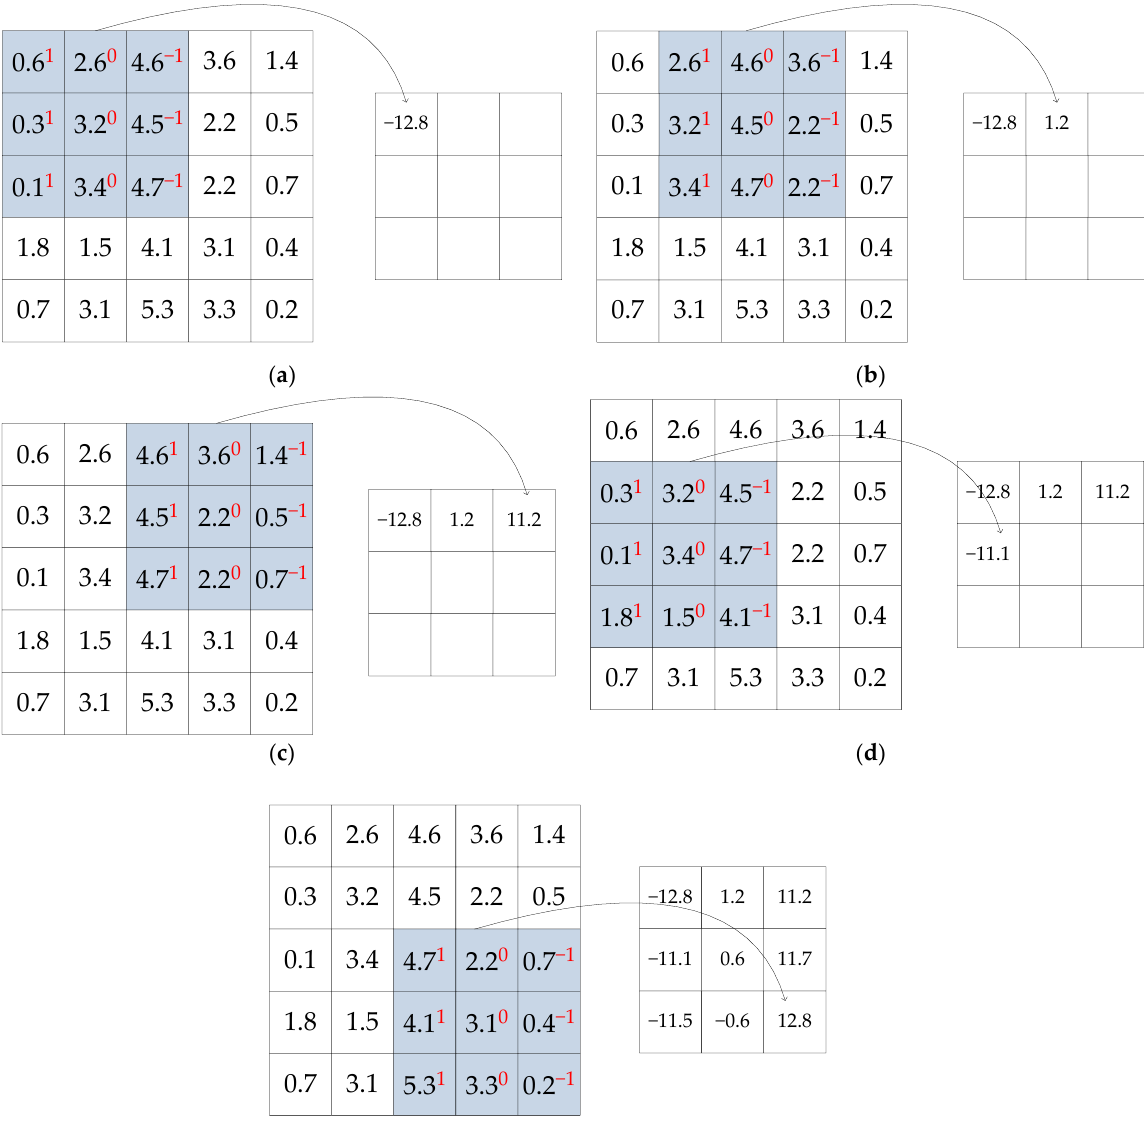
Figure 4. Convolutional neural network ( a ) input image, ( b ) amplitude value, and ( c ) convolution kernel.